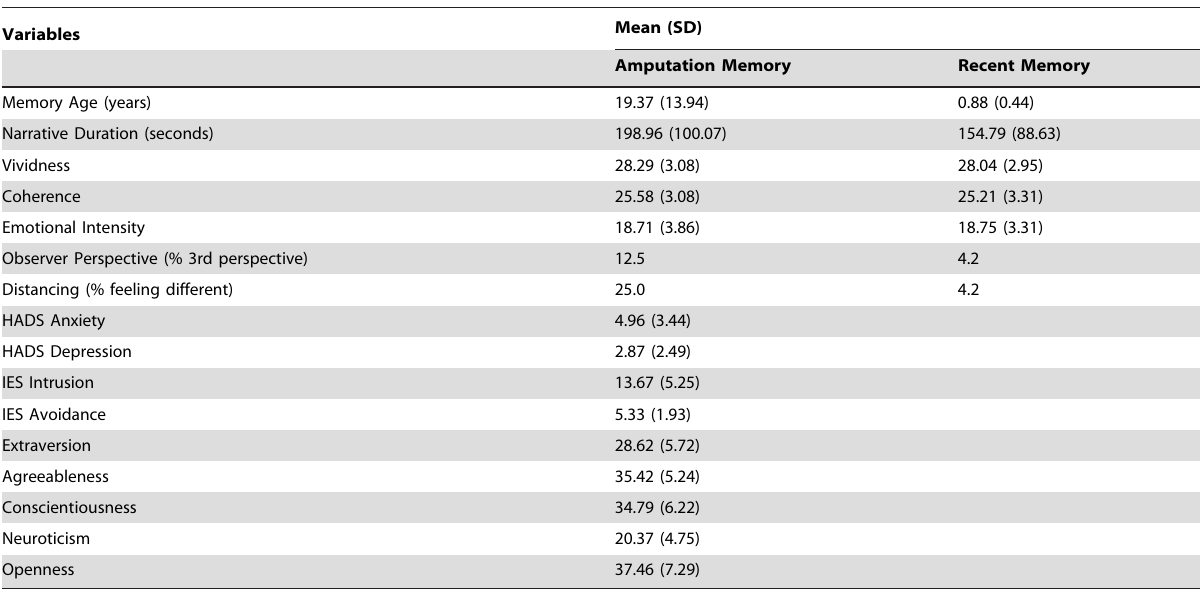
Table 1. Descriptive statistics for all study